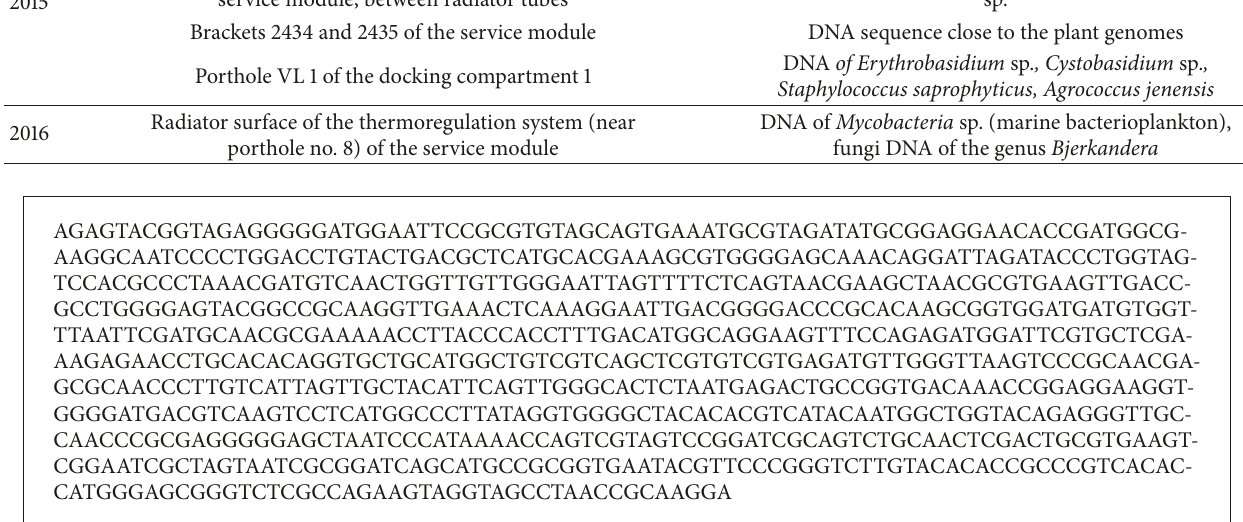
DNA of uncultivated soil bacteria from Madagascar and reservoirs DNA sequences close to the genomes of uncultured fungi DNA of Archaebacteria; DNA of fungi